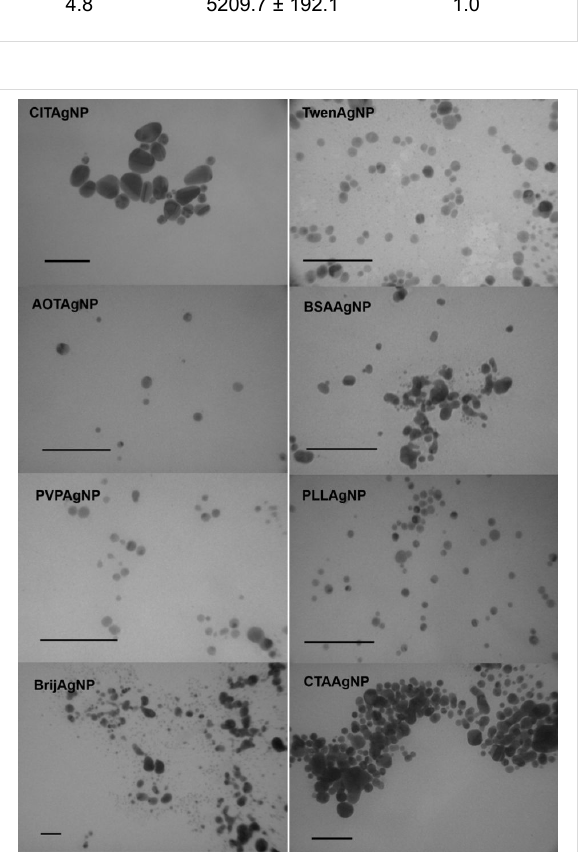
Figure 2: Transmission electron micrographs (TEM) of different silver nanoparticles coated with trisodium citrate (CITAgNP), sodium bis(2- ethylhexyl) sulfosuccinate (AOTAgNP), poly(vinylpyrrolidone) (PVPAgNP), Brij 35 (BrijAgNP), Tween 20 (TweenAgNP), bovine serum albumin (BSAAgNP), poly(L-lysine) (PLLAgNP), and cetyltrimethylammonium bromide (CTAAgNP). Scale bars are 100